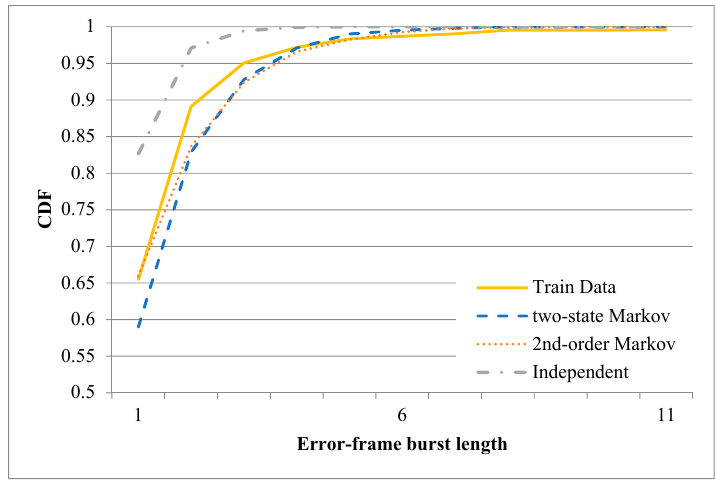
Figure 12. CDFs of correct-frame burst length derived using di ff erent error models based on recorded trace in the first minute of the tenth hour. Sensors 2020 , 20 , x FOR PEER REVIEW 12 of 20